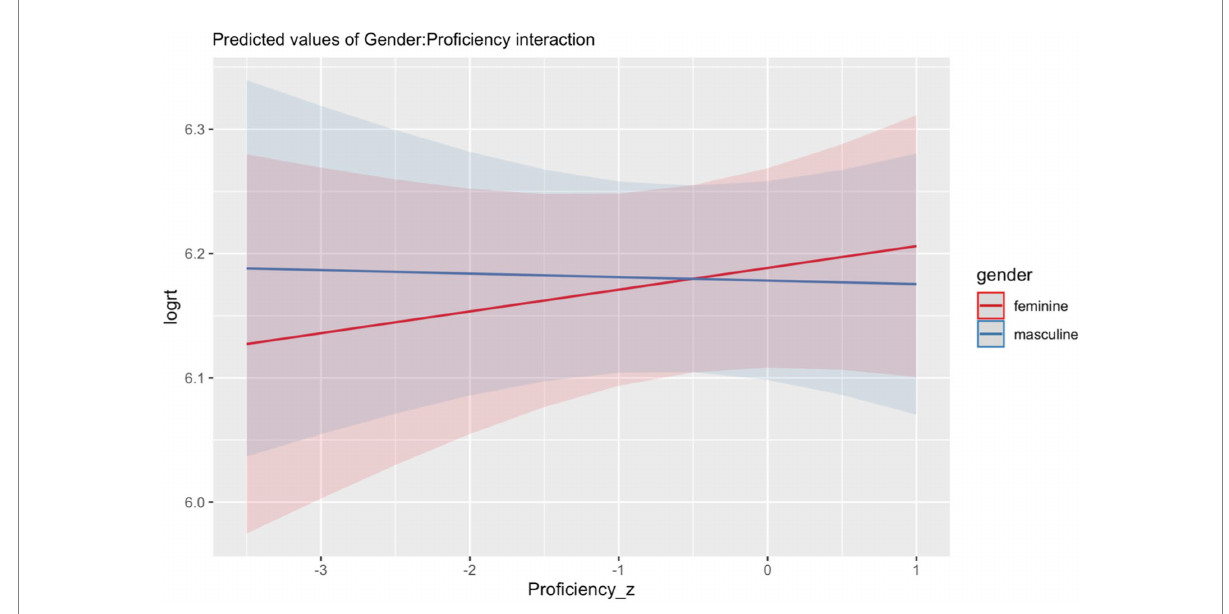
FIGURE 4 Illustration of the interaction between Gender (feminine, masculine) and Proficiency scores for Heritage